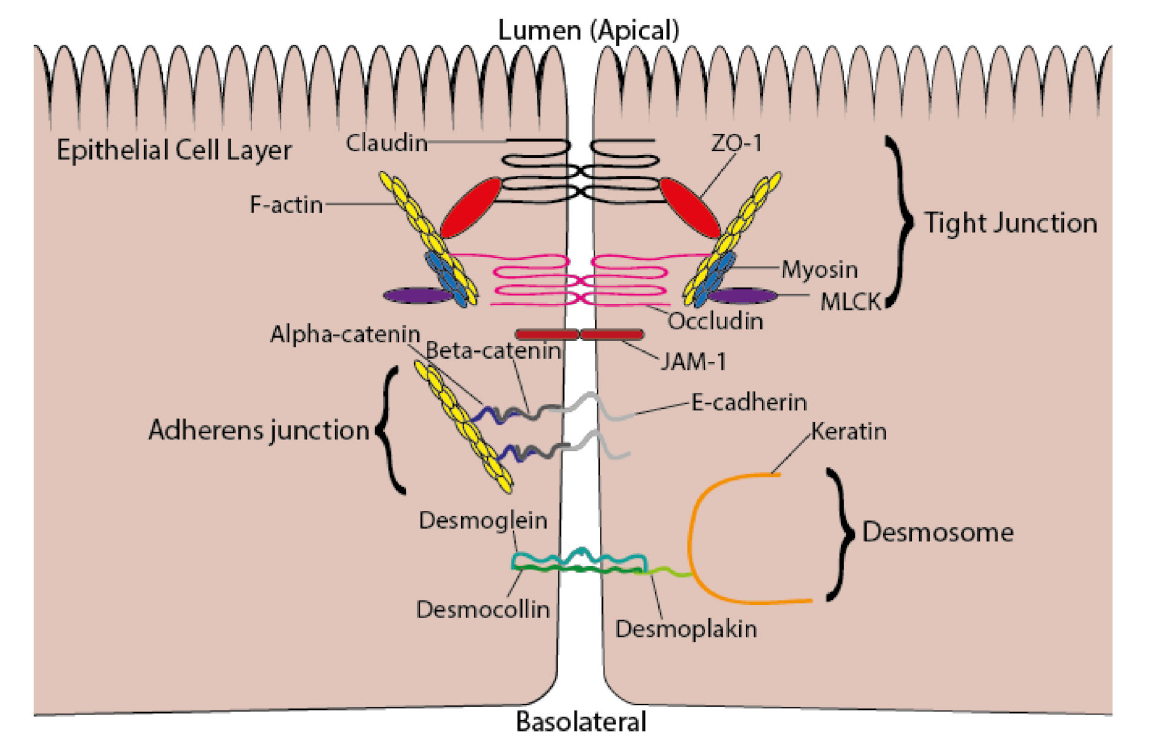
Figure 2. Intercellular junctions between epithelial cells consisting of tight junctions, adherens junctions, and desmosomes. Abbreviations used: ZO-1, zonula occludens-1; MLCK, myosin light chain kinase; JAM-1, junction adhesion